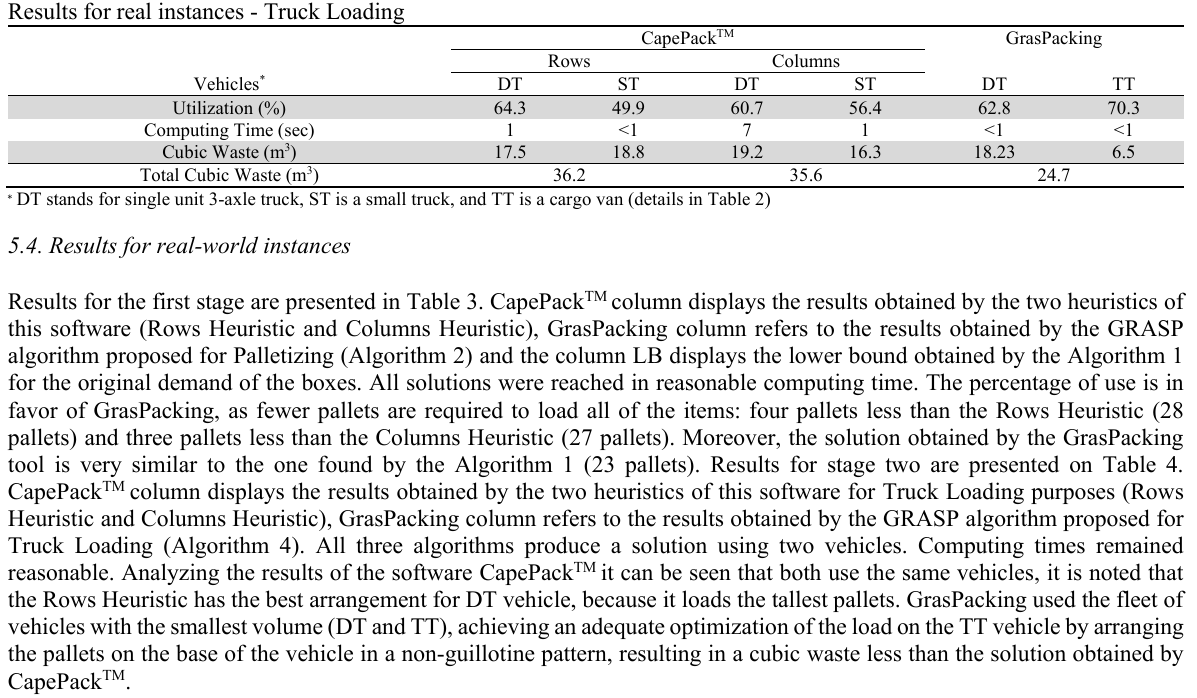
Results for real instances - Truck Loading